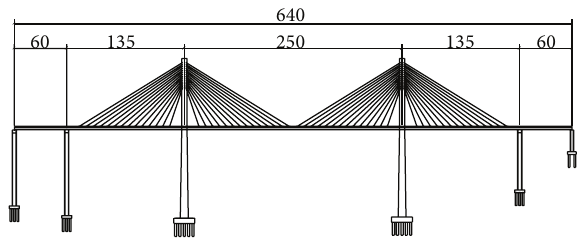
Figure 1: General arrangement of the cable-stayed bridge (unit: m).